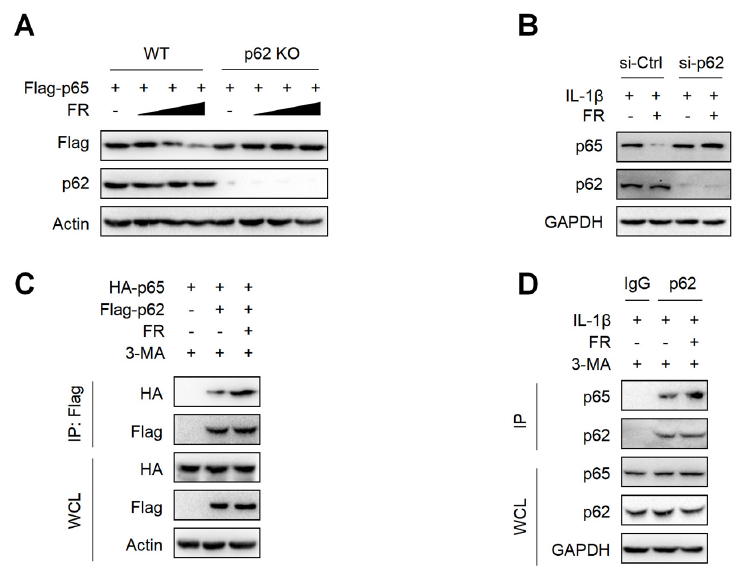
Figure 5. FR promotes the degradation of p65 via p62-mediated selective autophagy. ( A ) The Flag-p65 plasmid was transfected into WT and p62 knockout HEK293T cells for 24 h, and FR (0–40 µ M) was added for another 8 h. Finally, WB was used to detect the protein expression of Flag-p65 and p62. ( B ) Tenocytes were transfected with p62 siRNA for 24 h and then treated with IL-1 β (10 ng/mL) and FR (40 µ M) for 24 h. Finally, the protein expression of p65 and p62 was detected by WB. ( C ) HEK293T cells were transfected with HA-p65 and Flag-p62 plasmids for 24 h, then treated with 3-MA (5 mM) for 6 h, and then treated with FR (40 μ M) for another 8 h. Finally, cell proteins were collected for immunoprecipitation (IP). The expressions of HA-p65 and Flag-p62 proteins in IP samples and whole-cell lysates (WCL) were detected by WB. ( D ) Tenocytes were pretreated with 3-MA (5 mM) for 6 h, then stimulated with IL-1 β (10 ng/mL) and FR (40 μ M) for 24 h, and the cellular proteins were collected for IP. WB was used to detect the protein expression of p65 and p62 in IP samples and WCL. Data are expressed as the means ± SD from three independent experiments.